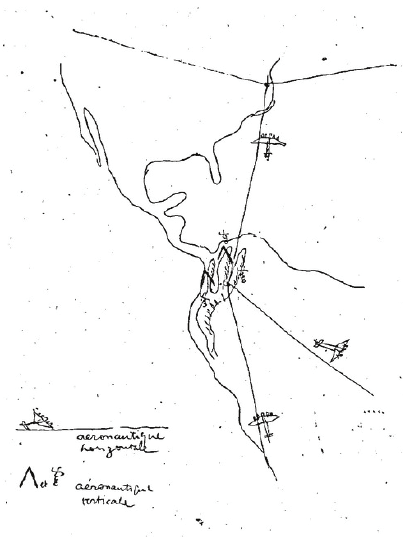
Fig. 10. Le Corbusier. “Urbanisme et aéronautique” (1947): „ San Francisco-New York, París, Moscú, Bogotá, Santiago, Rio, Buenos Aires .a new human adventure“